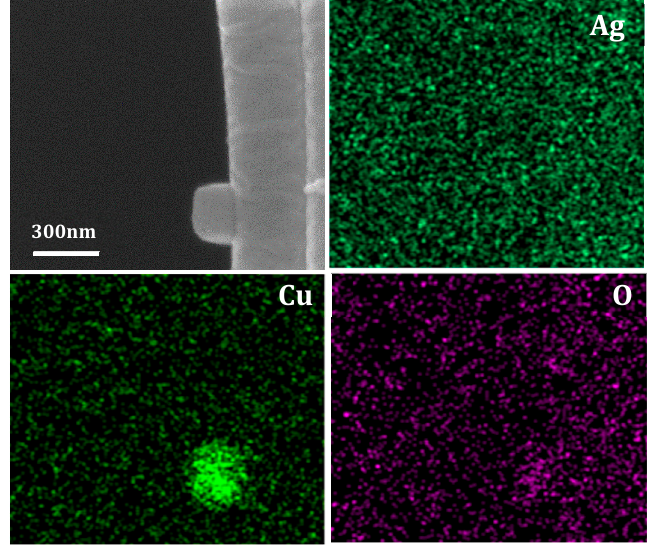
Figure 4. SEM and EDS mapping of copper nanocubes on aligned